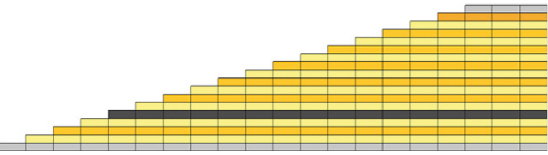
Figure 2: Diagram of composite multilayer panel